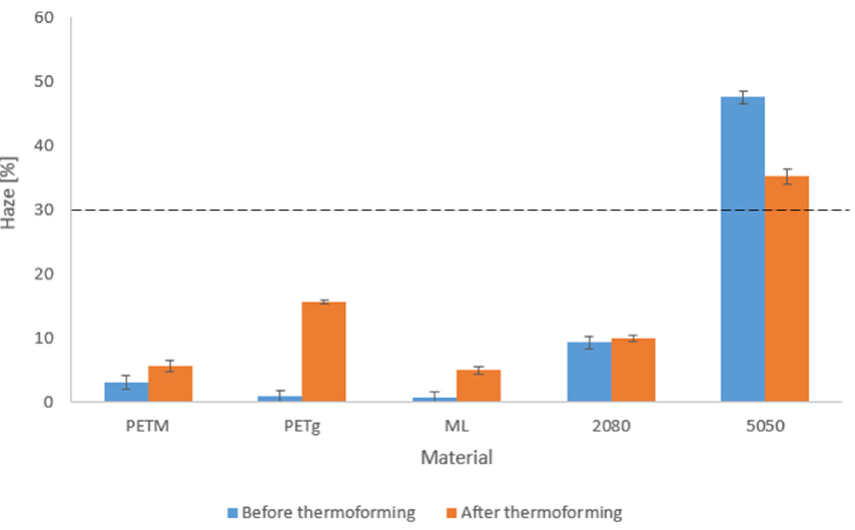
Table 4. Thicknesses of the extruded sheets, and the thermoformed trays.